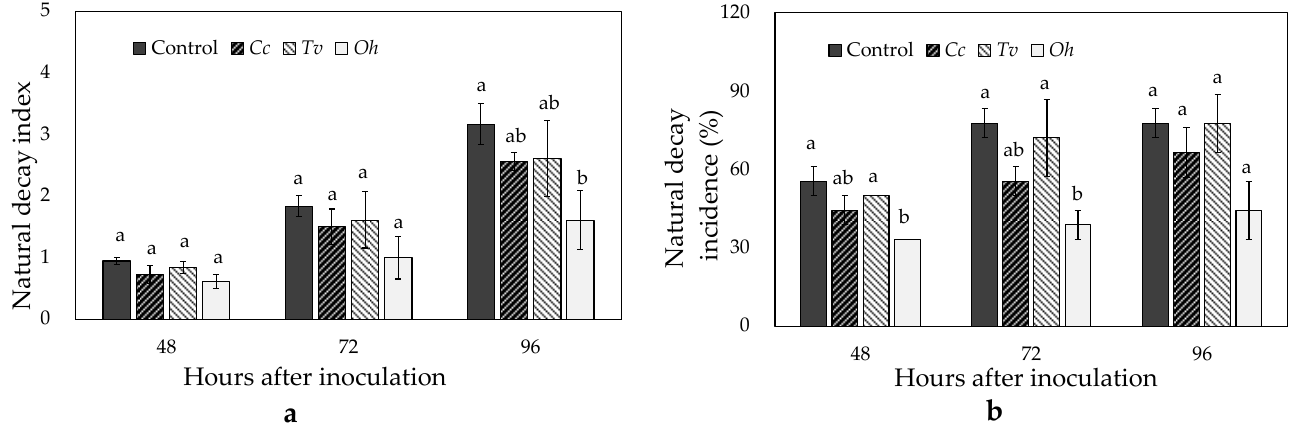
Figure 6. Effects of Cymbopogon citratus ( Cc ), Thymus vulgraris ( Tv ), and Origanum heracleoticum ( Oh ) essential oil vapor treatments on natural decay index ( a ) and natural decay incidence ( b ) of strawberry fruit after harvest. Each value represents the mean of four replicates. Means with different letters are significantly different based on Ducan’s test ( p ≤ 0.05).